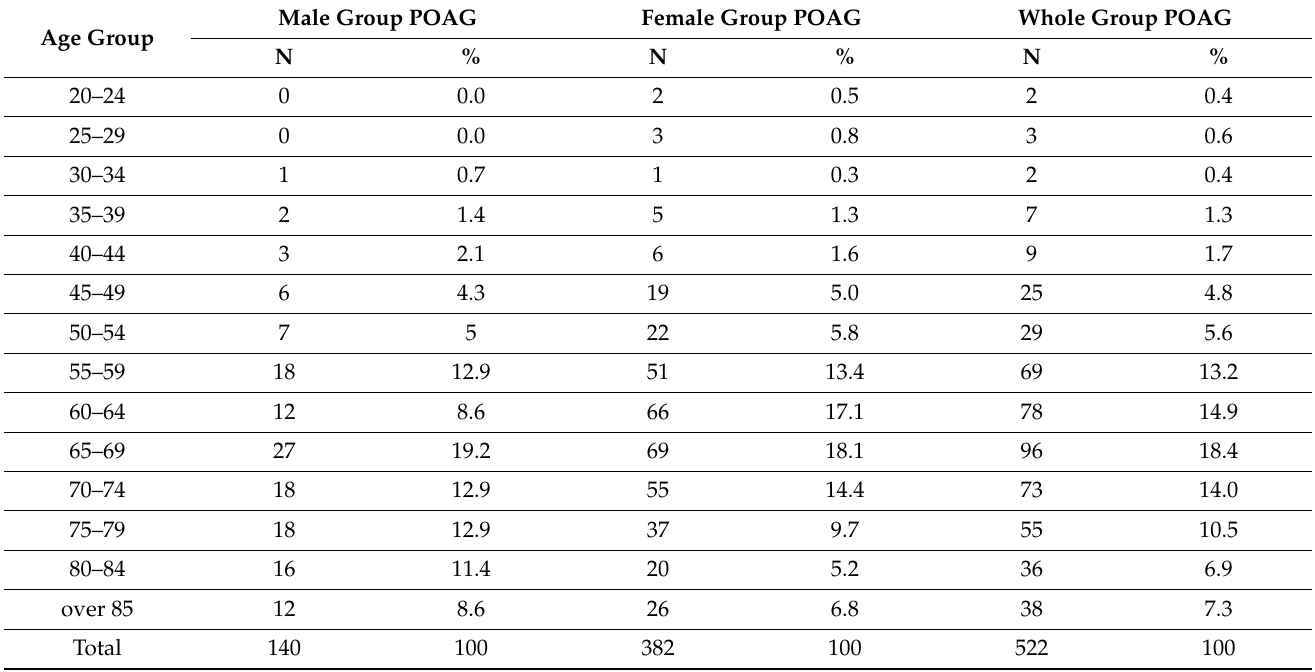
Table 4. Distribution of glaucoma patients by gender and age group at the last